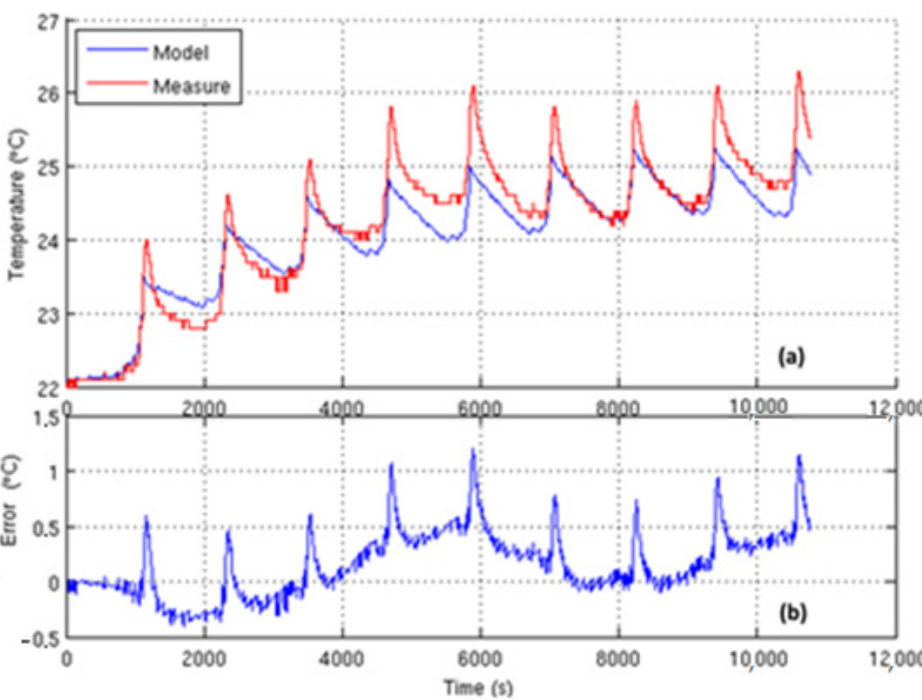
Figure 19. Comparison of cell temperature between experimental and numerical results: ( a ) measured and calculated cell temperatures, ( b ) absolute error.